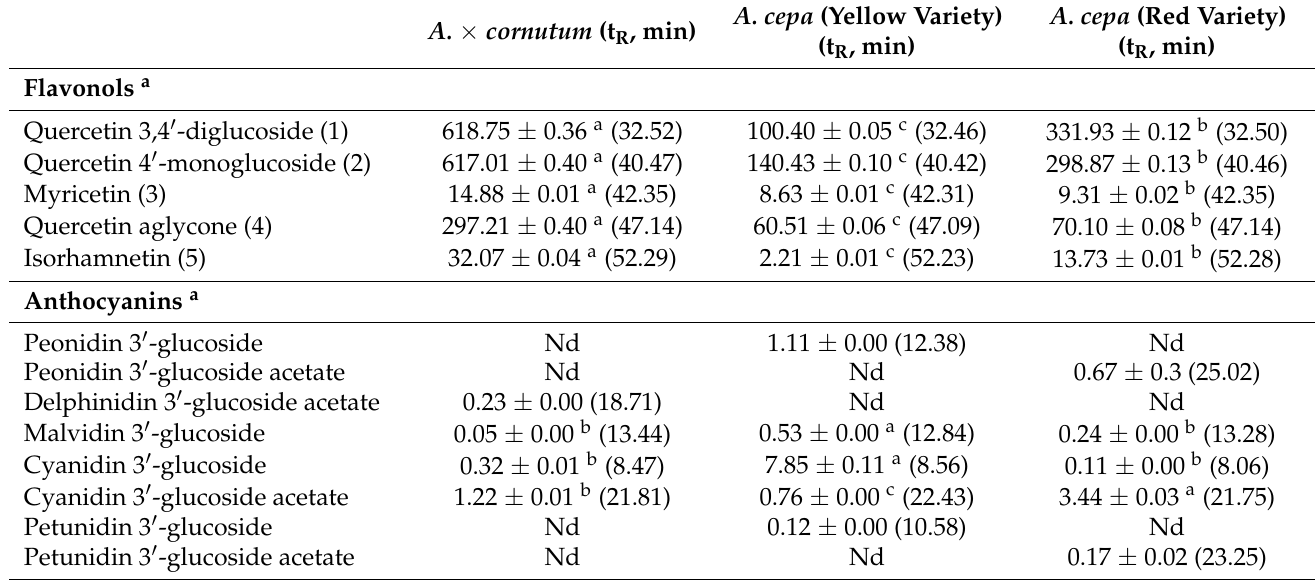
Table 1. HPLC quantification of flavonols and anthocyanins in two varieties of A. cepa and A. × cornutum extracts. A. × cornutum (t R ,